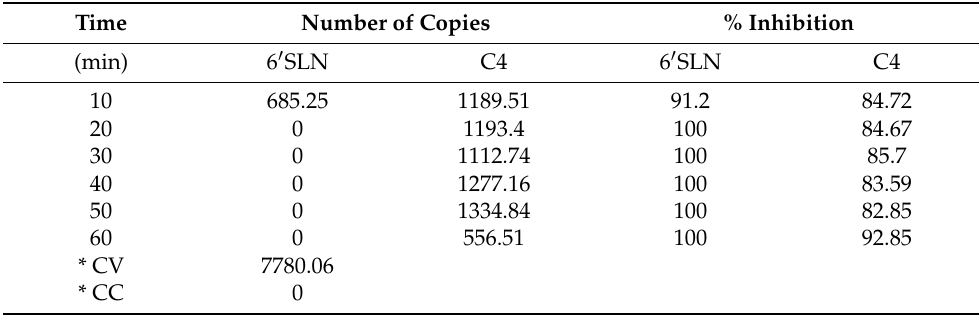
Table 3. Copy number of the NP gene of virus A/Yucatan/2370/09 co-treated with the C4 fraction